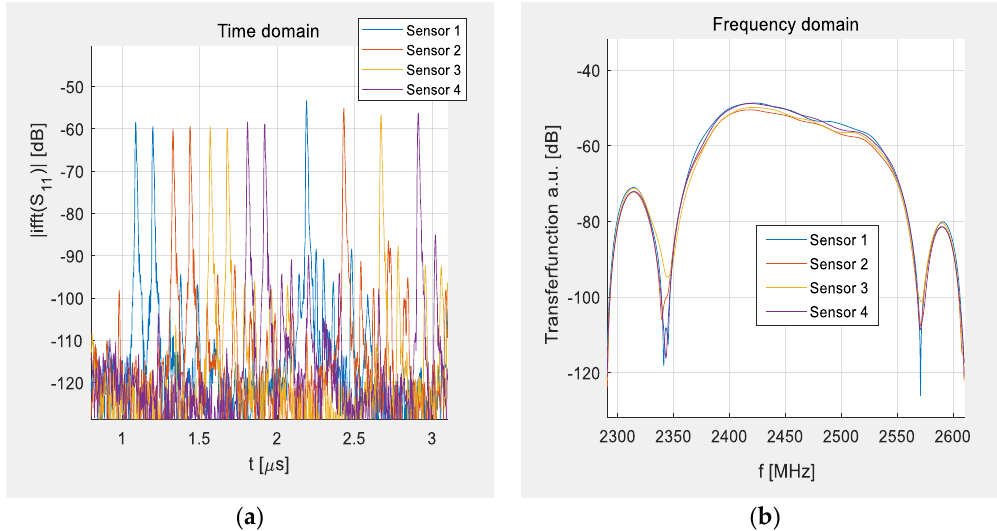
Figure 3. Measured S-parameters of four individual sensors: ( a ) left: time domain, the different sensor responses are shown in different colors; ( b ) right: frequency domain, all sensors show the same transfer function — a wideband plateau so that the interrogation in the ISM band can happen successfully no matter of the temperature shift.